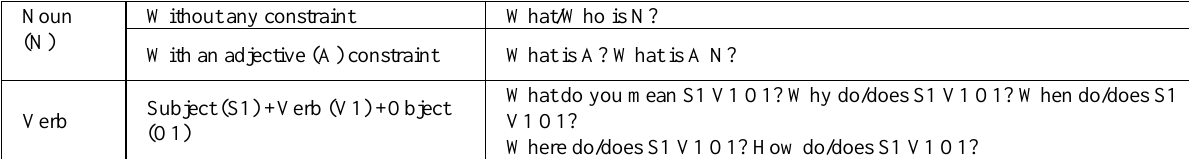
Table 2 . Template for the right type of questions